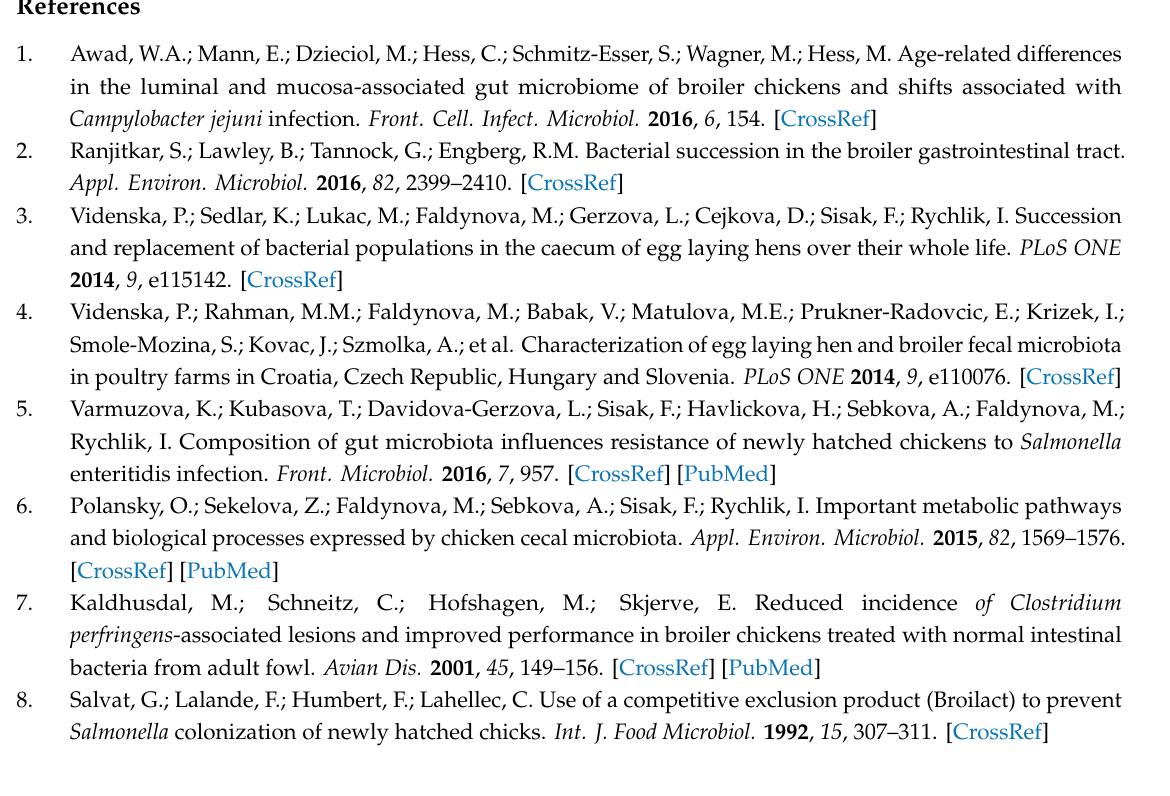
Figure S1: Unweighted PCoA visualisation of gut microbiota composition in the caecum of newly hatched chicks. Figure S2: Salmonella counts in the caecum of 12-day-old chicks inoculated with di ff erent anaerobes on day 1 of life and challenged with S. Enteritidis on day 8. Table S1: OTU table of OTUs forming at least 0.05% of all microbiota in at least one of the tested samples. Table S2: List of strains used in this study. Table S3: Bacterial strains and numbers of chicks used in di ff erent experiments. Table S4: Feed composition, light, and temperature regime used during